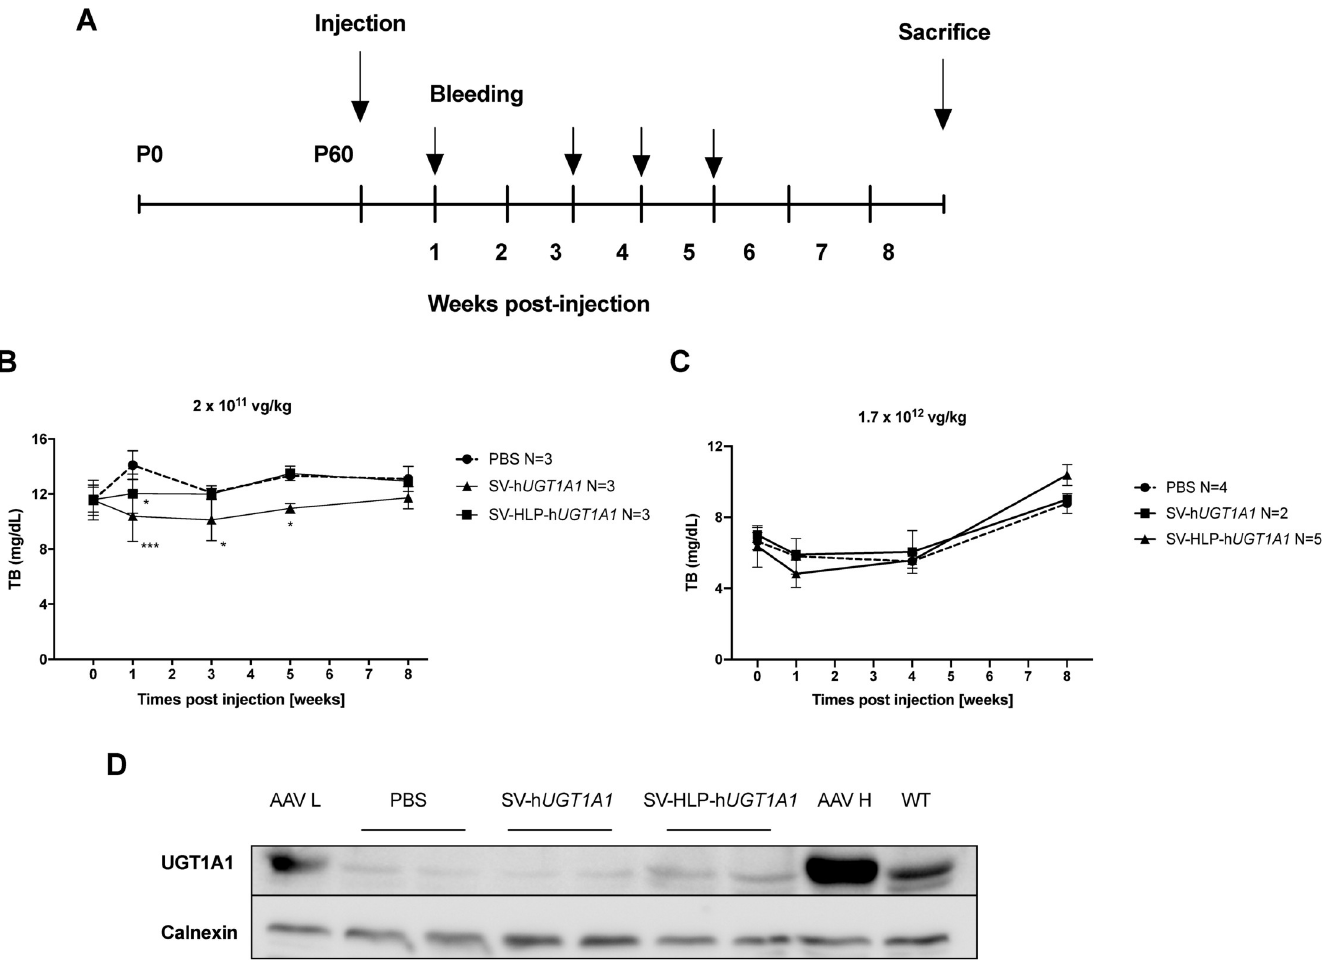
Fig 4. Insertion of liver specific promoter does not improve the low efficacy of rSV40 vectors in vivo . (A) 60-day-old Ugt1a -/- mice were treated with rSV- h UGT1A1 , rSV-HLP-h UGT1A1 , or PBS via tail vein injection. (B-C) Total serum bilirubin (mg/dL) was monitored overtime until week 8 after injection. (D) Presence of UGT1A1 in Ugt1a1 deficient mice treated with 1x10 11 vg/kg of AAV8-h UGT1A1 (AAV L), PBS, 1.7x10 12 vg/kg of rSV-hUGT1A1, 1.7x10 12 vg/kg of rSV-HLP- h